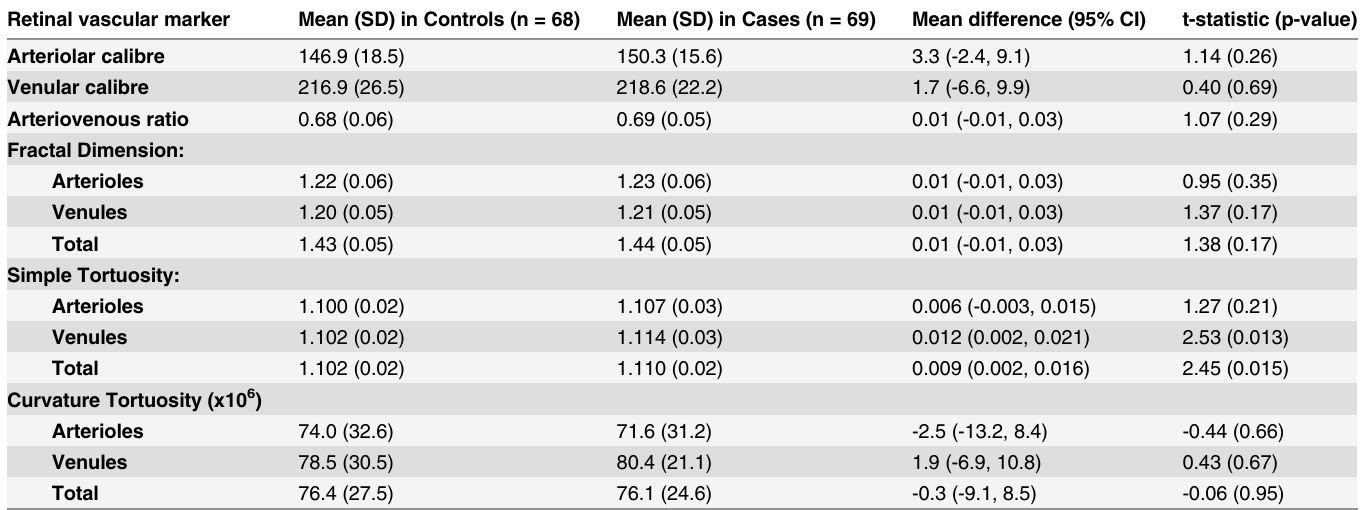
Table 2. Retinal vascular marker distributions in cases and controls.